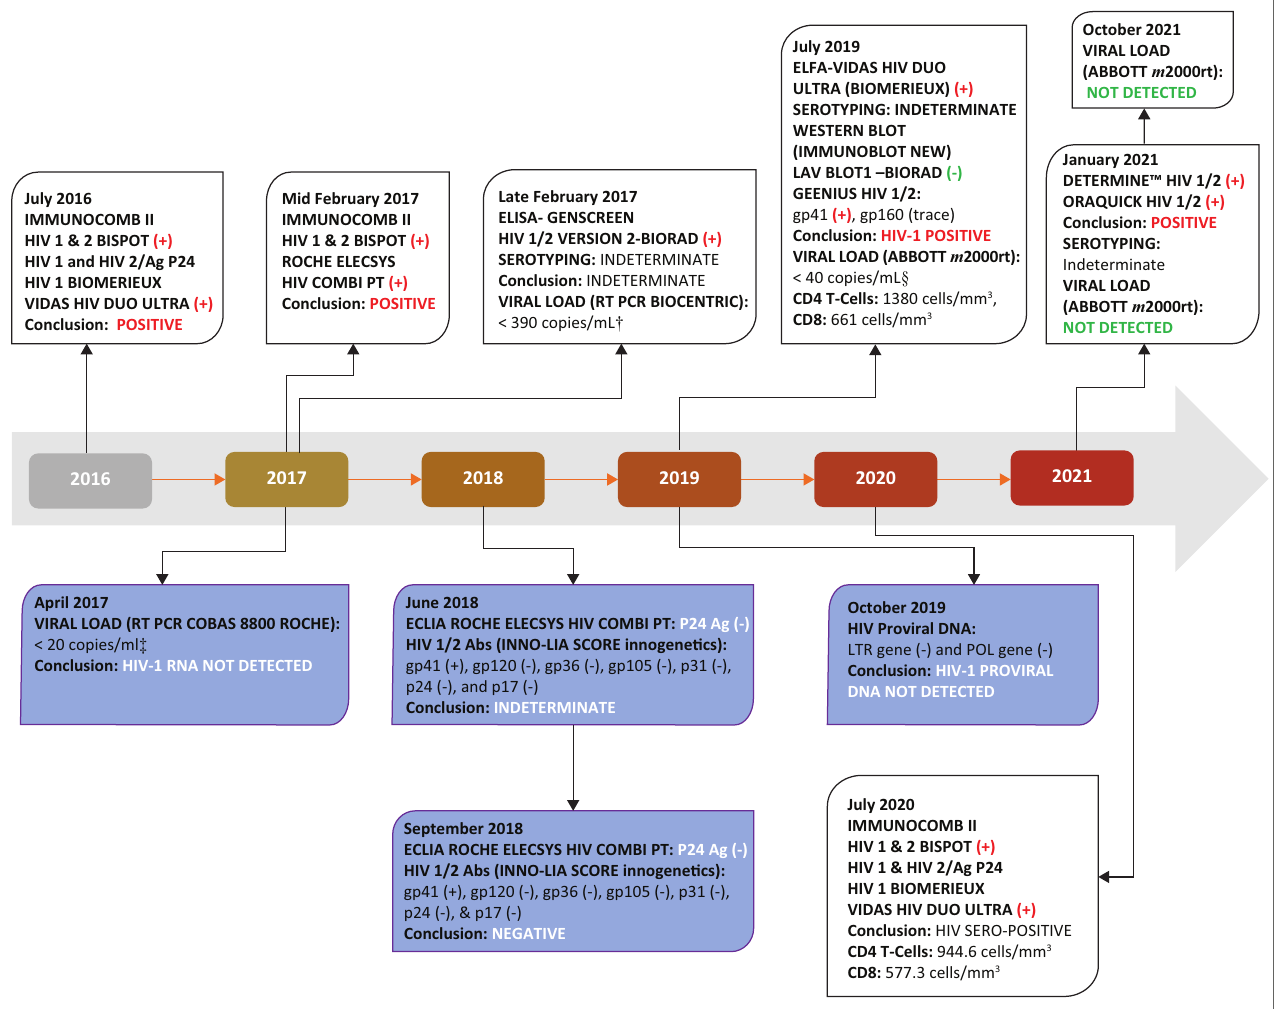
FIGURE 1: Summary of the testing performed in the patient’s history from 2016 to 2021,